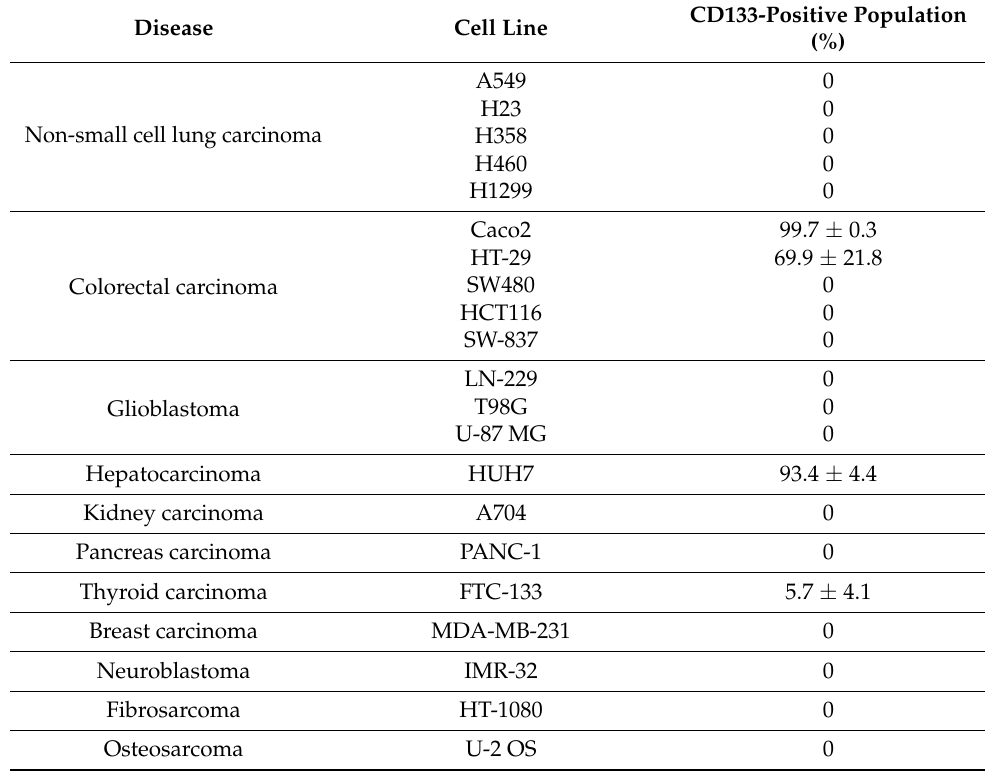
Table 1. CD133 expression in cancer cell lines. The mean values of the percentages of CD133-positive cells ( n = 5; mean ±